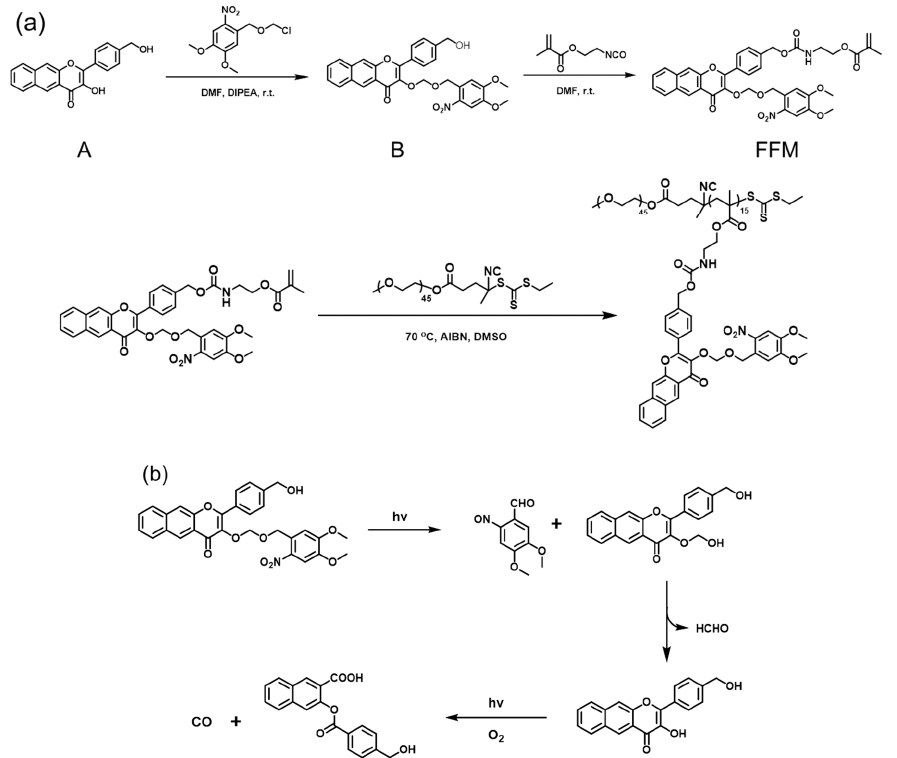
Figure 2. ( a , b ) TEM images of aqueous dispersions (0.1 g/L) of PCOFA micelles ( a ) without and ( b ) with irradiation for 2 h; ( c ) intensity-average hydrodynamic distributions of PCOFA micelles